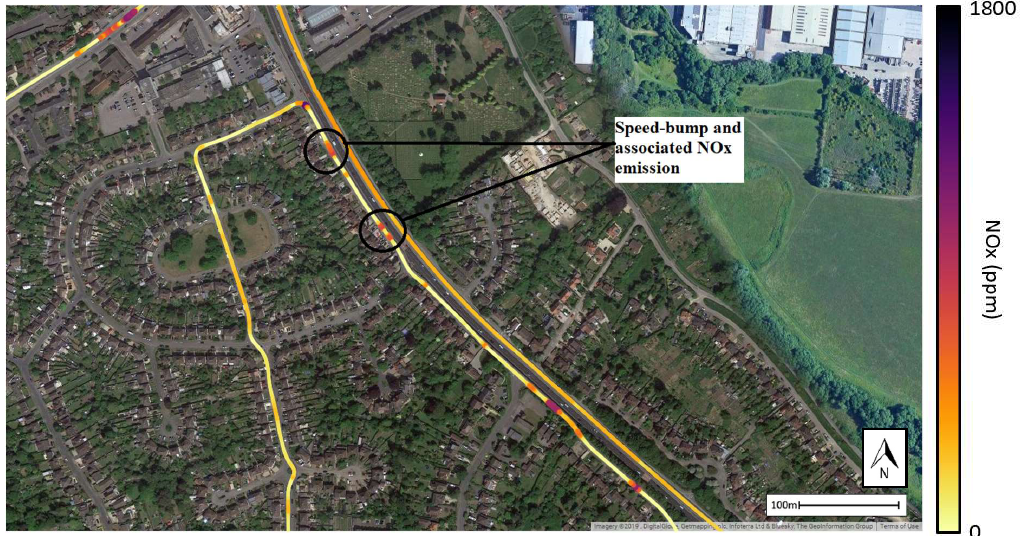
Figure 12. NO x emissions from the Euro V bus going over speed bumps. Not all speed-bumps are